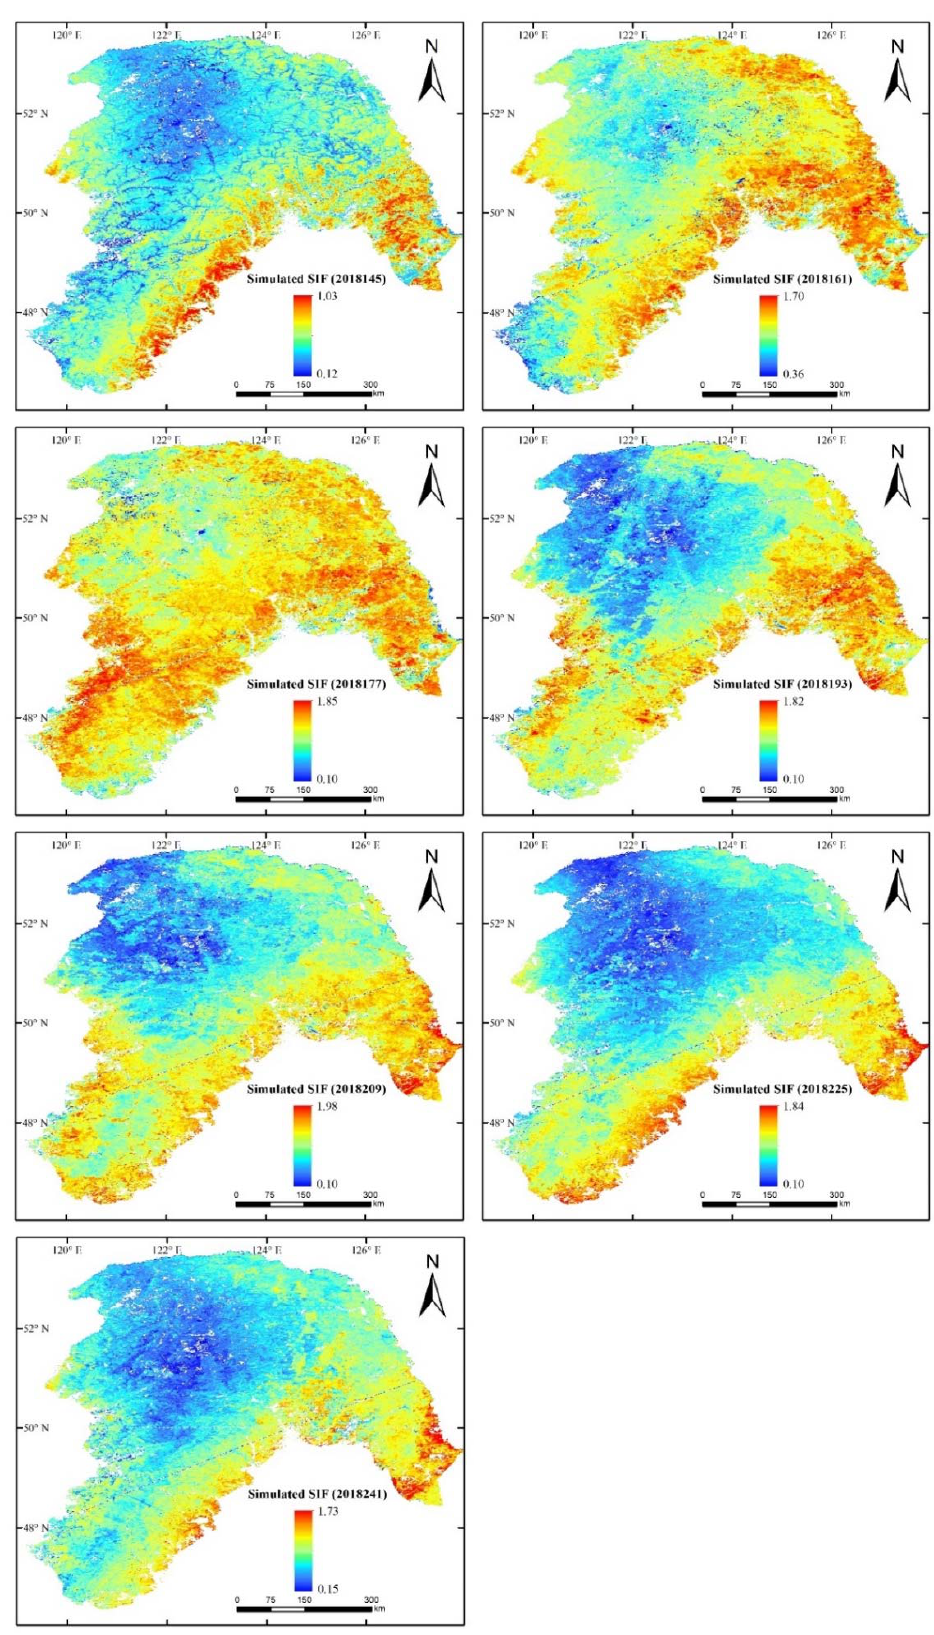
Figure 13. Simulated 16 ‐ day SIF in 2018 based on EVI and temperature.